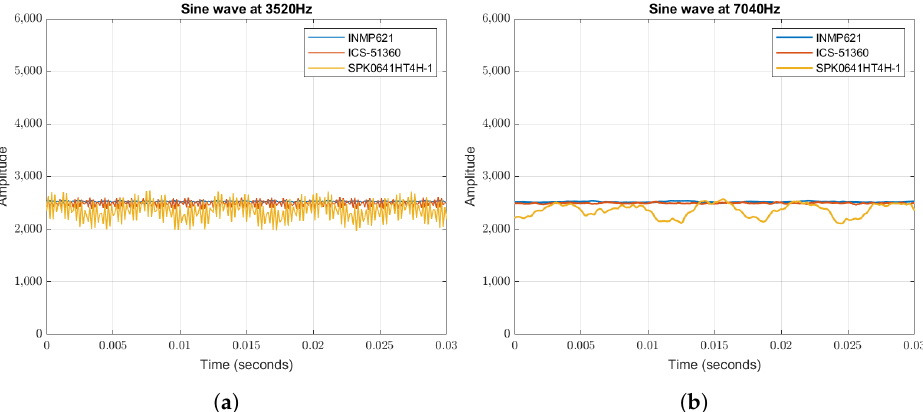
Figure 10. Sine wave acquisition for frequencies above the filter’s passband. ( a ) Sine wave at 3520 Hz. ( b ) Sine wave at 7040